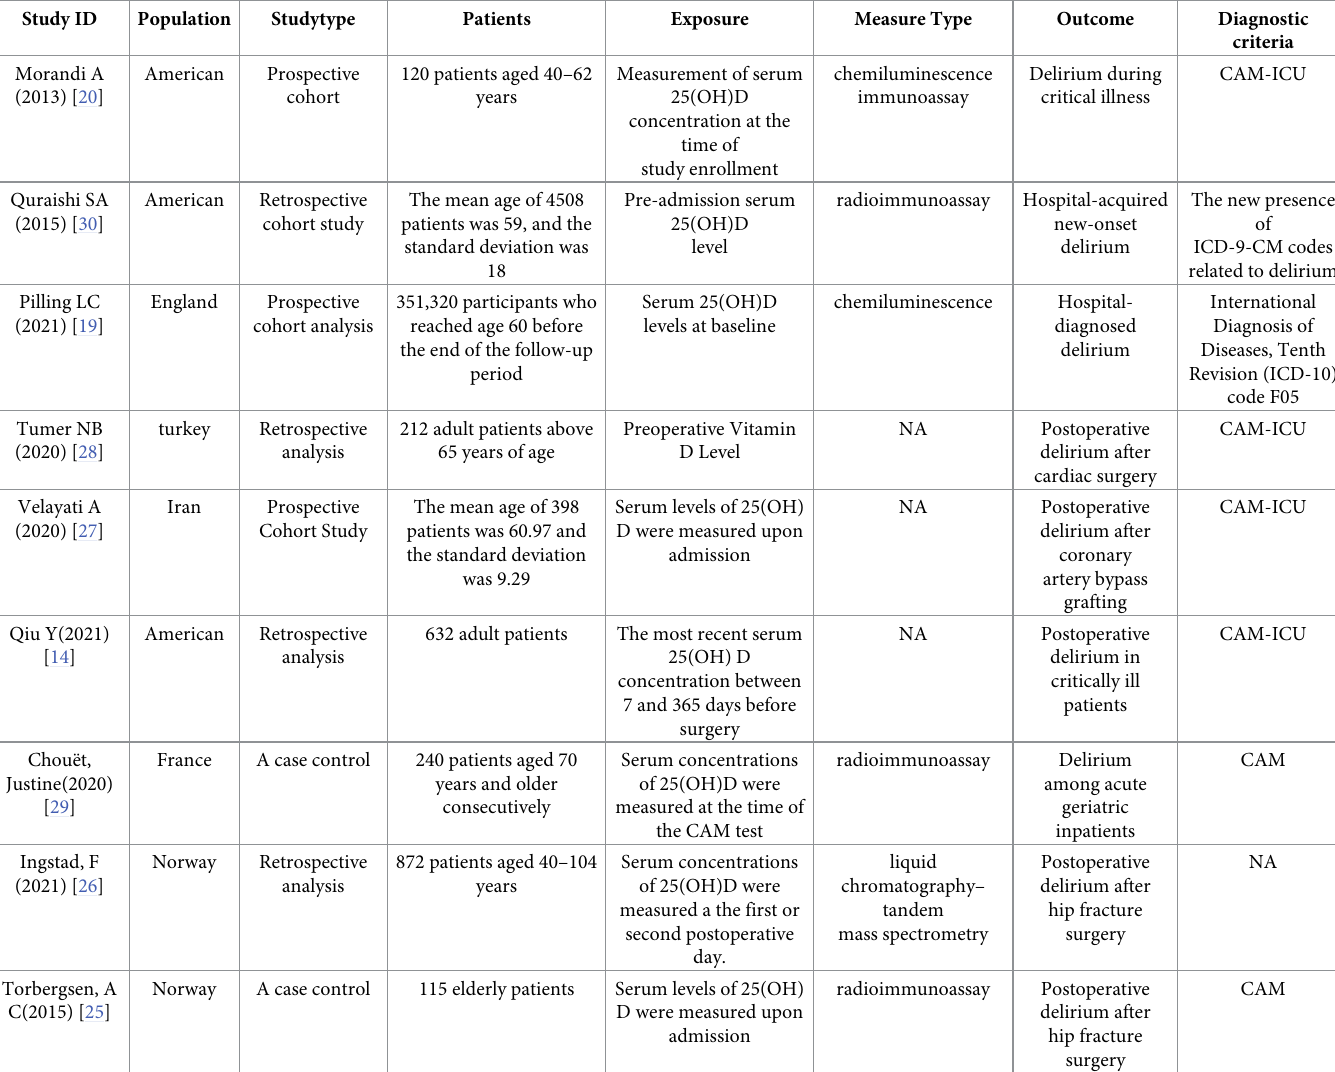
Table 1. The basic characteristics of the included